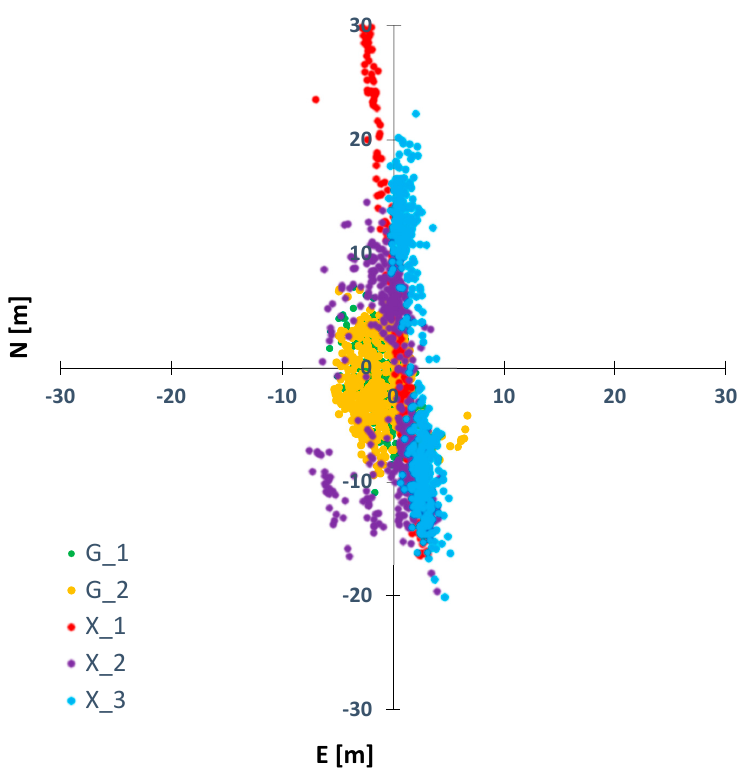
Figure 9. Plot of NE component deviations of linear measurement with code receivers.